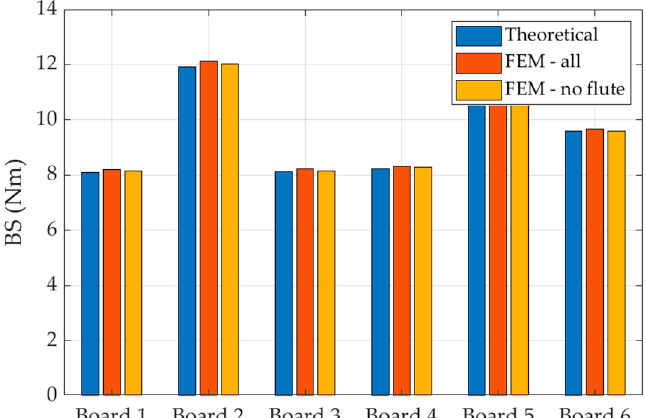
Figure 10. BS calculated by a theoretical model for all 6 boards in which only flat layers are active (blue bars) and by two numerical models where corrugated layers are included in the calculation (red bars) or are excluded from the calculation (yellow bars). Table 4. The bending stiffness computed by the numerical model with included fluting with different number of periods. FEM-2–a model with two periods (see Figure 9a), FEM-4–a model with four periods (see Figure